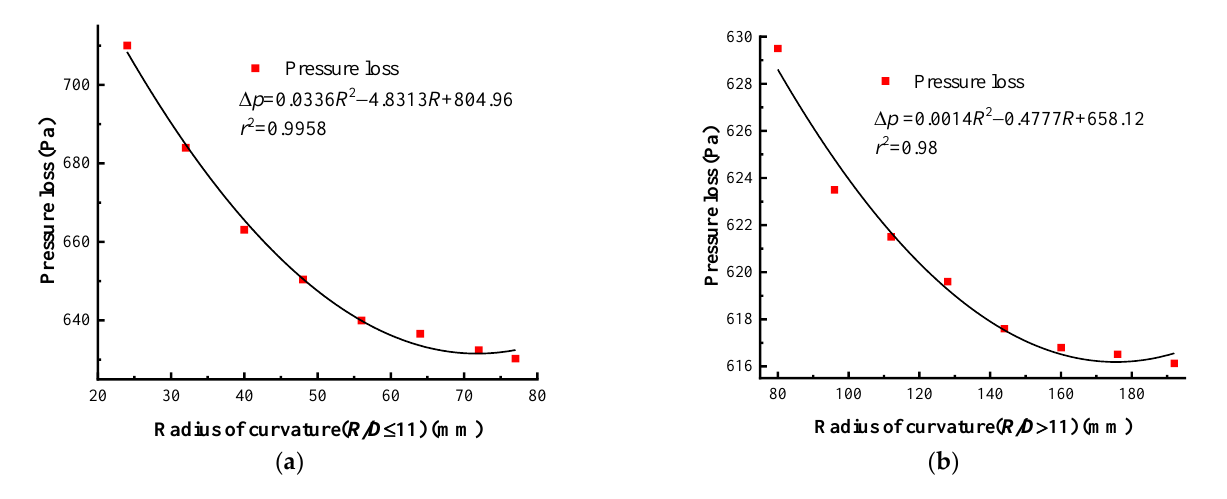
Figure 6. Correction curve for the relationship between curvature radius and pressure loss: ( a ) relationship curve between R and ∆ p ( R / D ≤ 11); ( b ) relationship curve between R and ∆ p ( R / D > 11).